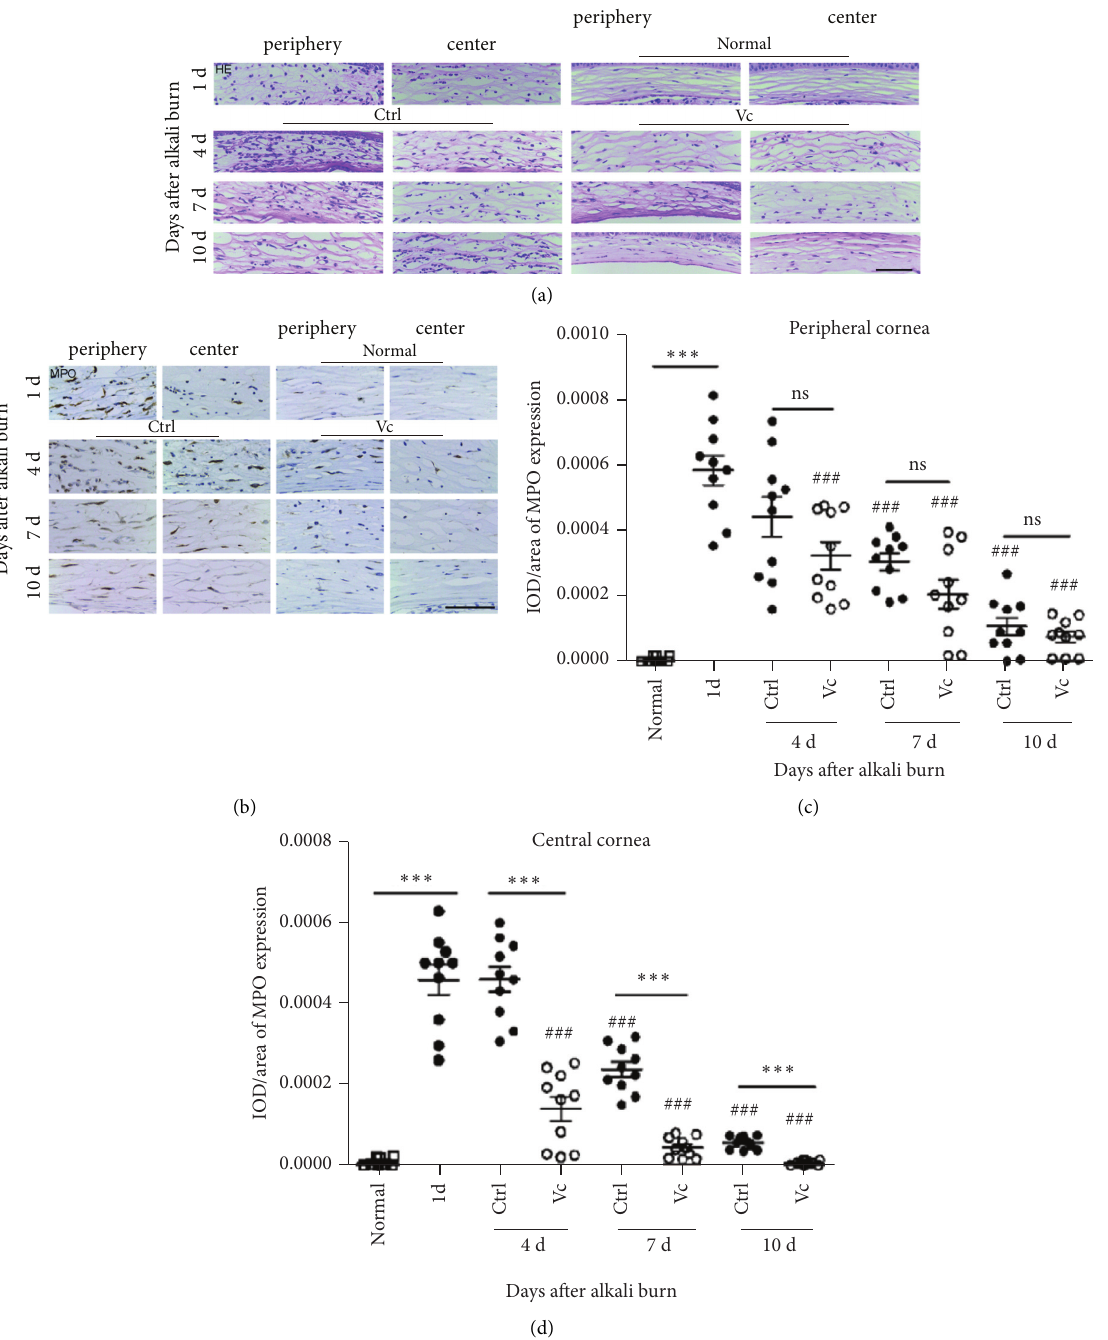
Figure 4: Vitamin C inhibits the infiltration of the inflammatory cells. (a) The hematoxylin and eosin stains of the corneas of the two groups. (b) MPO immunohistochemical staining of the center and periphery of the cornea. (c, d) IOD/area of the MPO in the central and peripheral areas of the cornea. Abbreviations: Ctrl, control group (sterile water group); Vc, Vitamin C group; ns, no significant difference between the indicated groups. ∗ Means the comparison of Vc group and control group. # Means the comparison with day 1. ∗ p < 0 . 05, ∗∗ p < 0 . 01, and # p < 0 . 05. Scale bar � 50 μ m. IOD means integral optical density, and MPO is